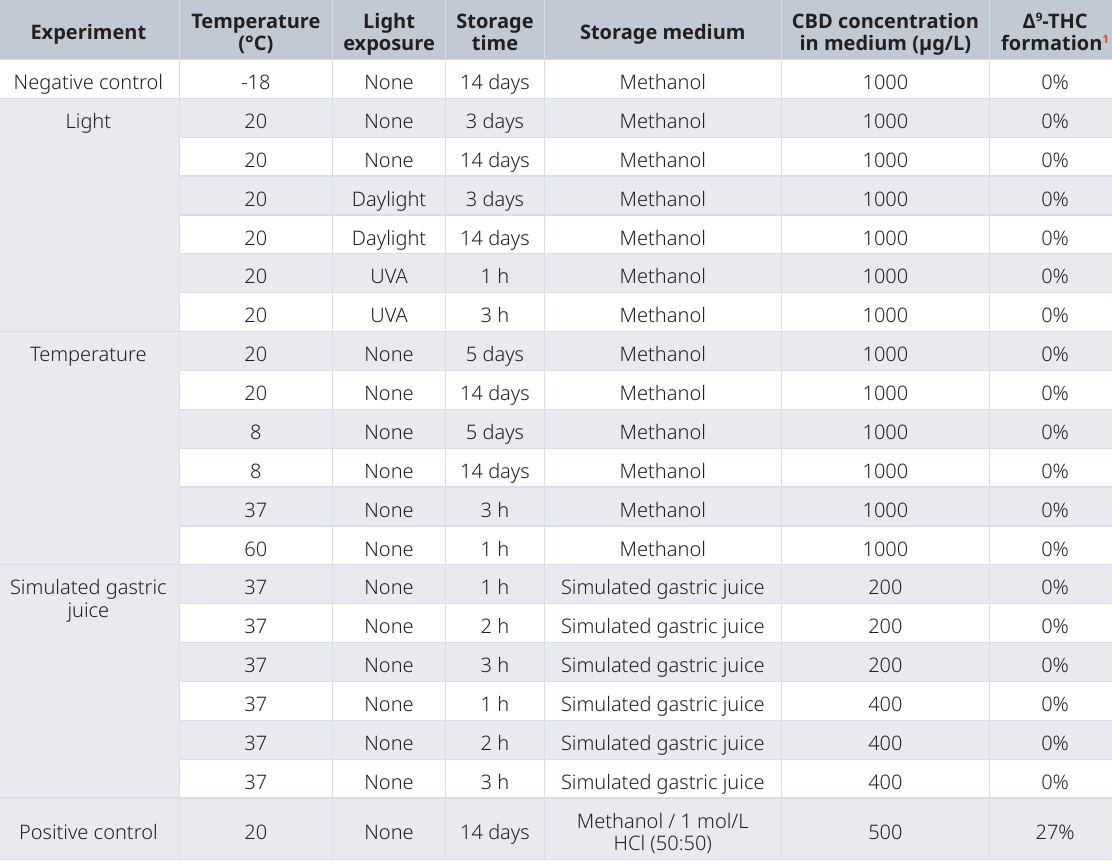
Table 1. Cannabidiol (CBD) stability experiments under various storage